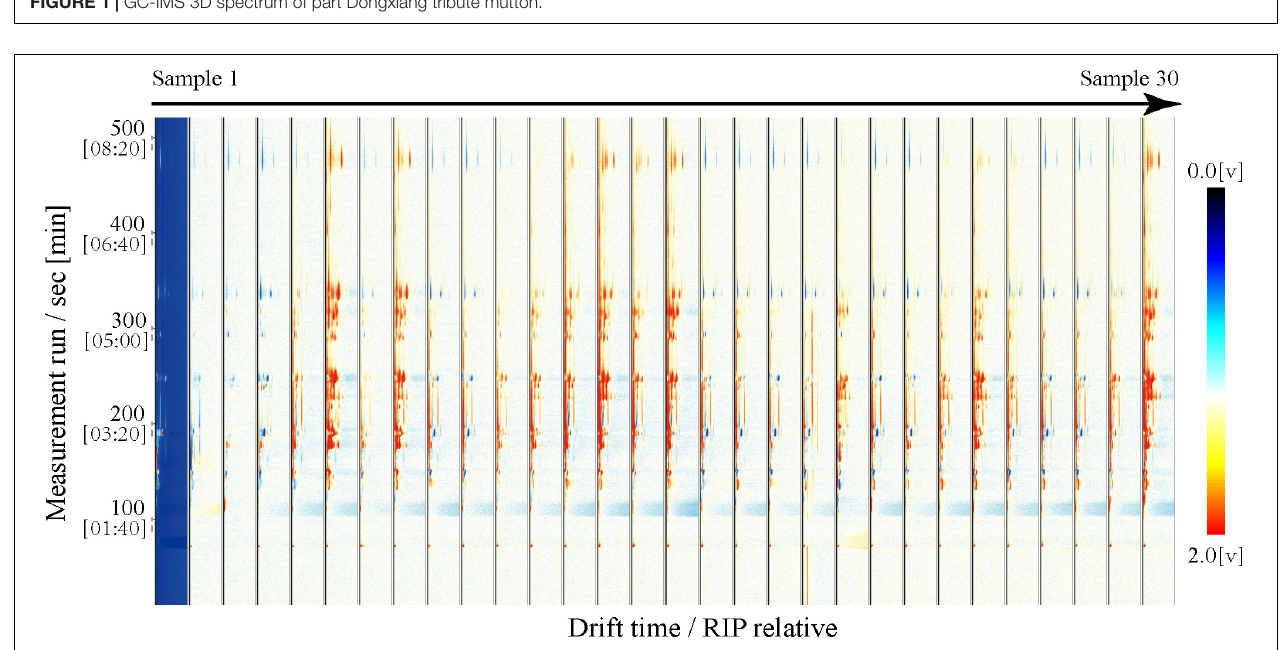
FIGURE 1 | GC-IMS 3D spectrum of part Dongxiang tribute mutton.